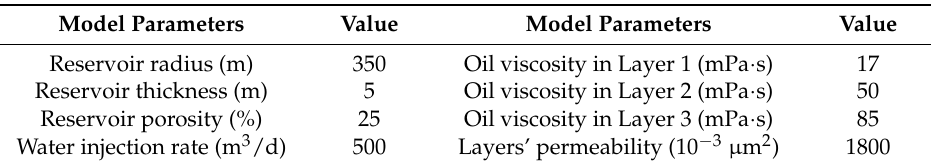
Table 2. Main parameters of the model (for viscosity ratio).